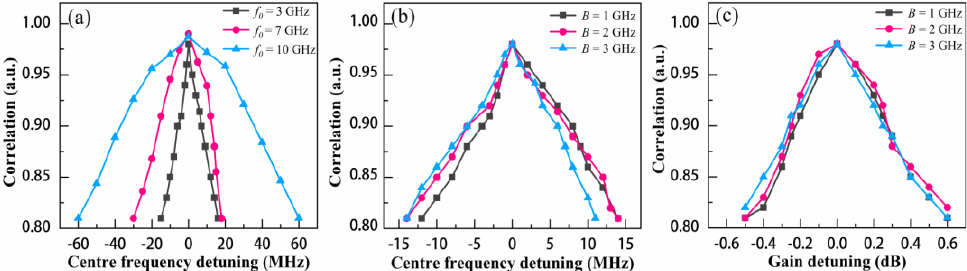
Figure 5. Correlation coefficient versus ( a ) centre frequency detuning mismatch for different centre frequencies, ( b ) centre frequency detuning mismatch for different BPF widths, and ( c ) amplifier gain detuning for different BPF widths.